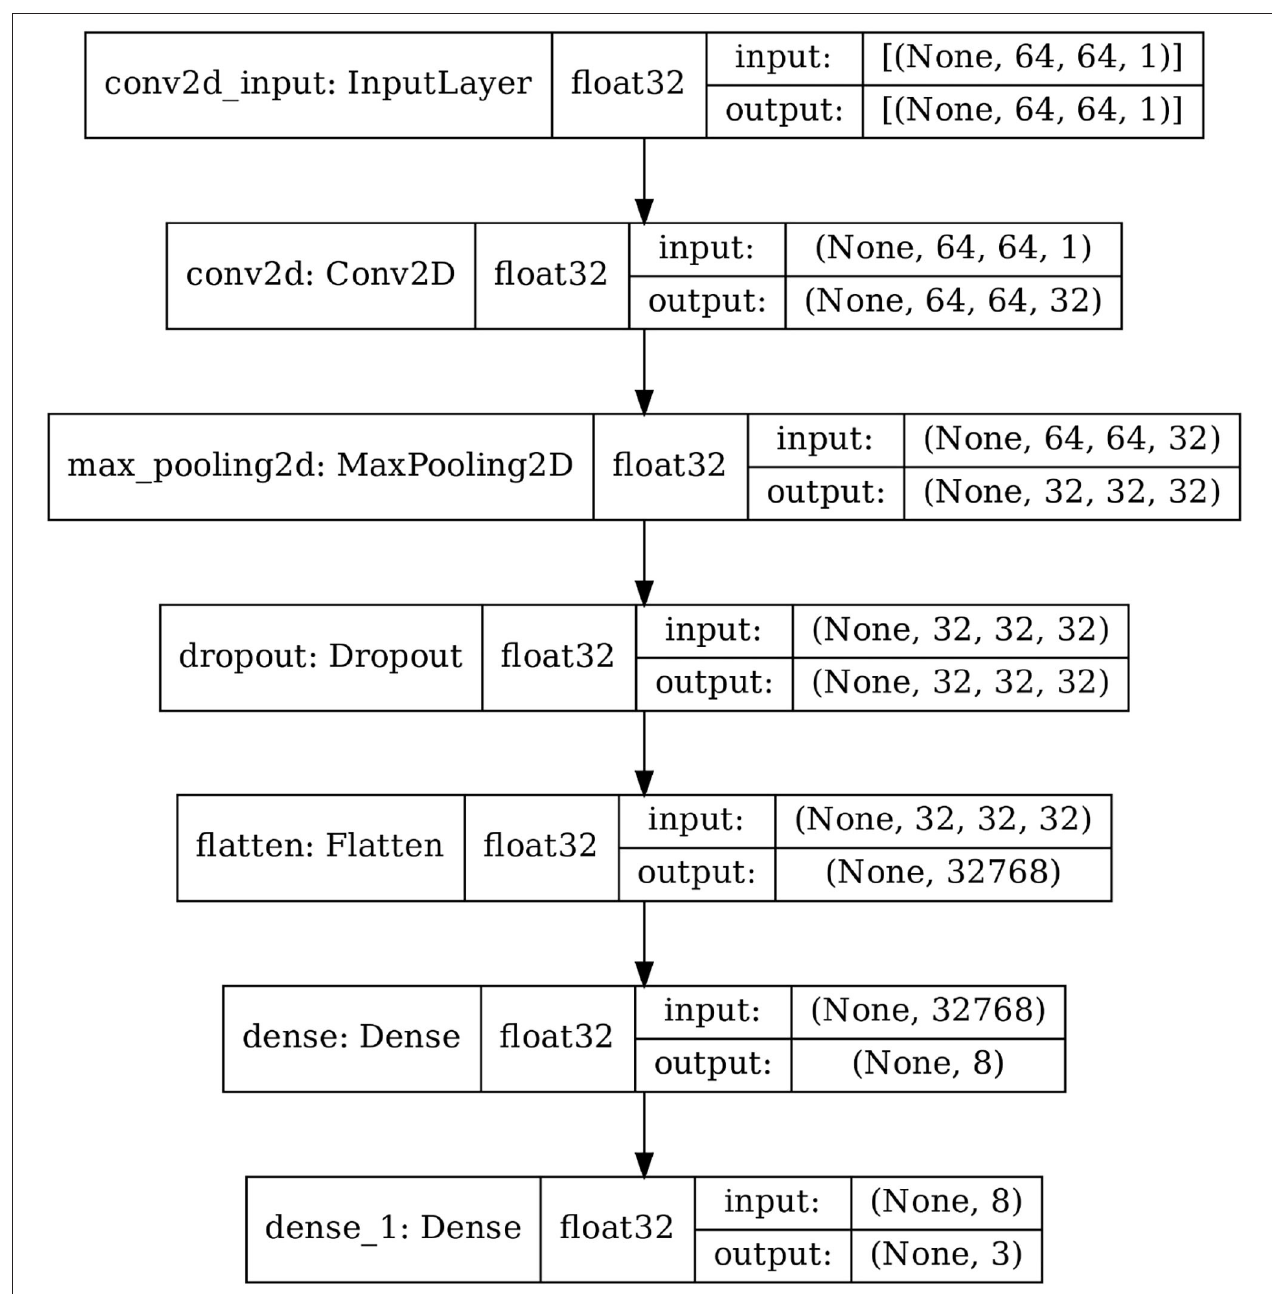
FIGURE 5 | Network architecture of CNN01